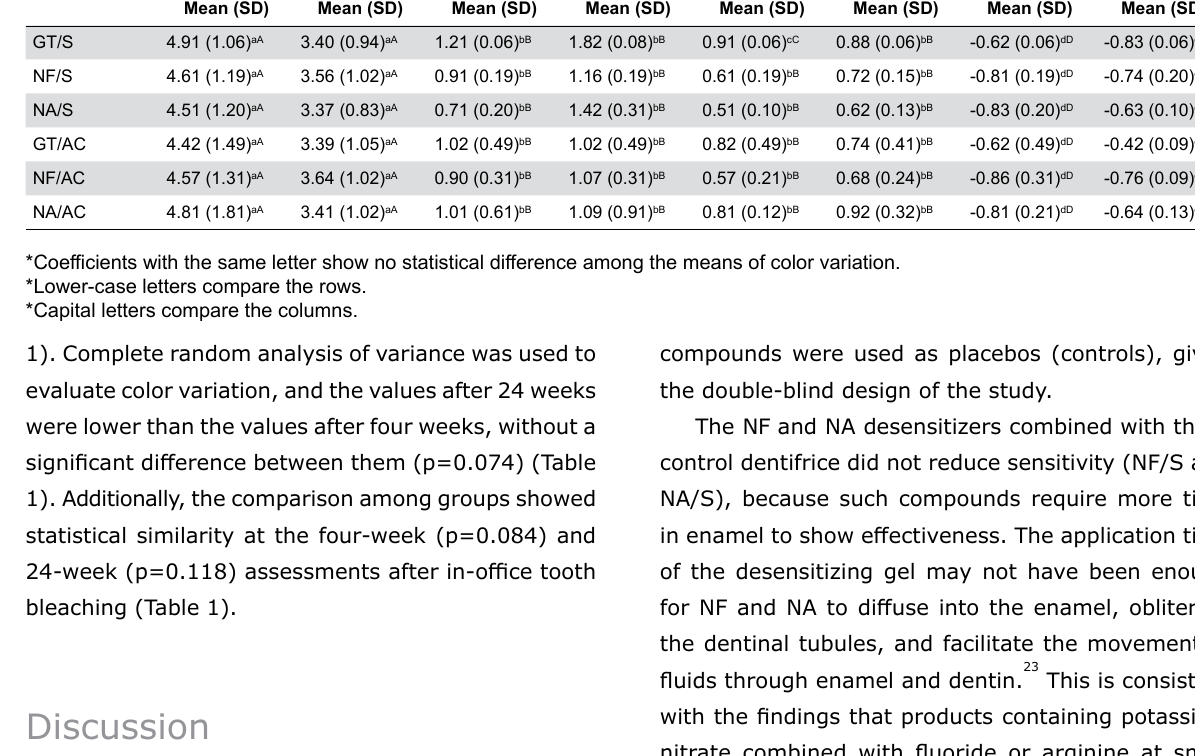
Table 1- Tukey’s test results for ΔE values and their parameters after four and twenty four weeks